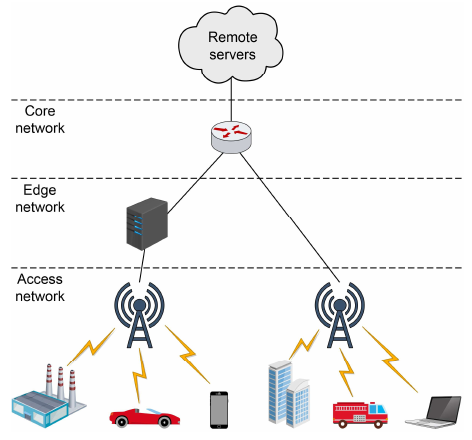
Figure 12. Edge computing